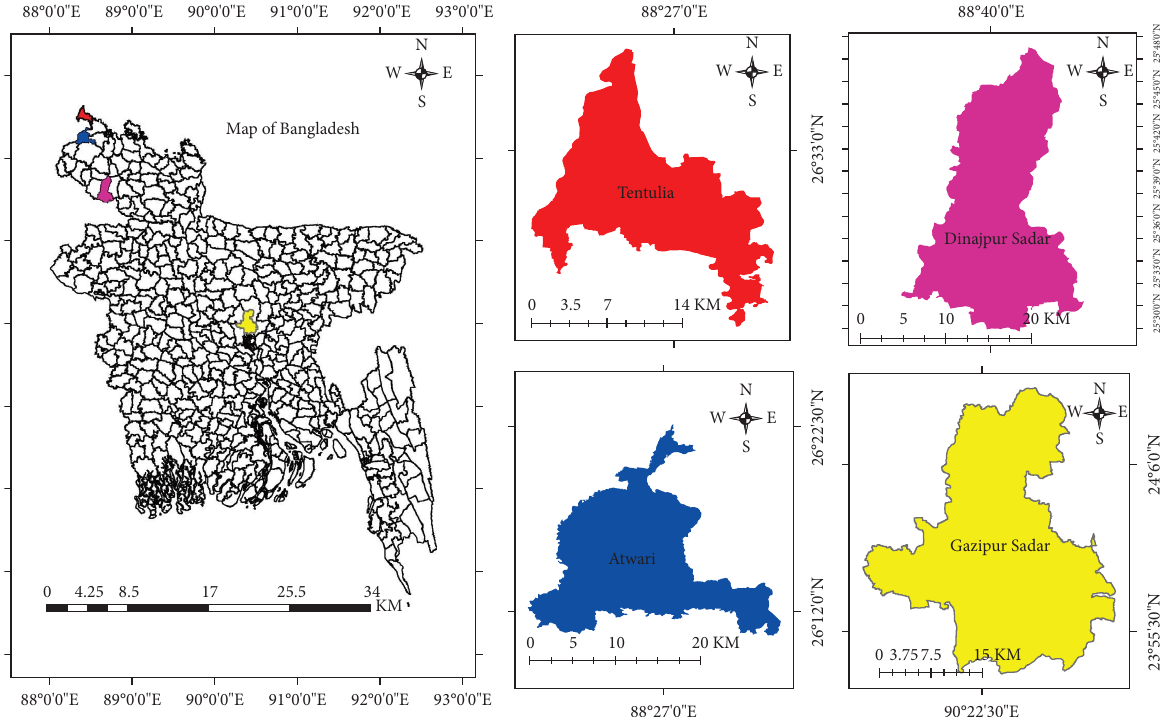
Figure 1: Location of the sampling sub-districts (Upazila) of Bangladesh marked by diferent colors. Map is created in ArcGIS 10.8.2. ArcGIS Enterprise, ESRI, Redlands, California,